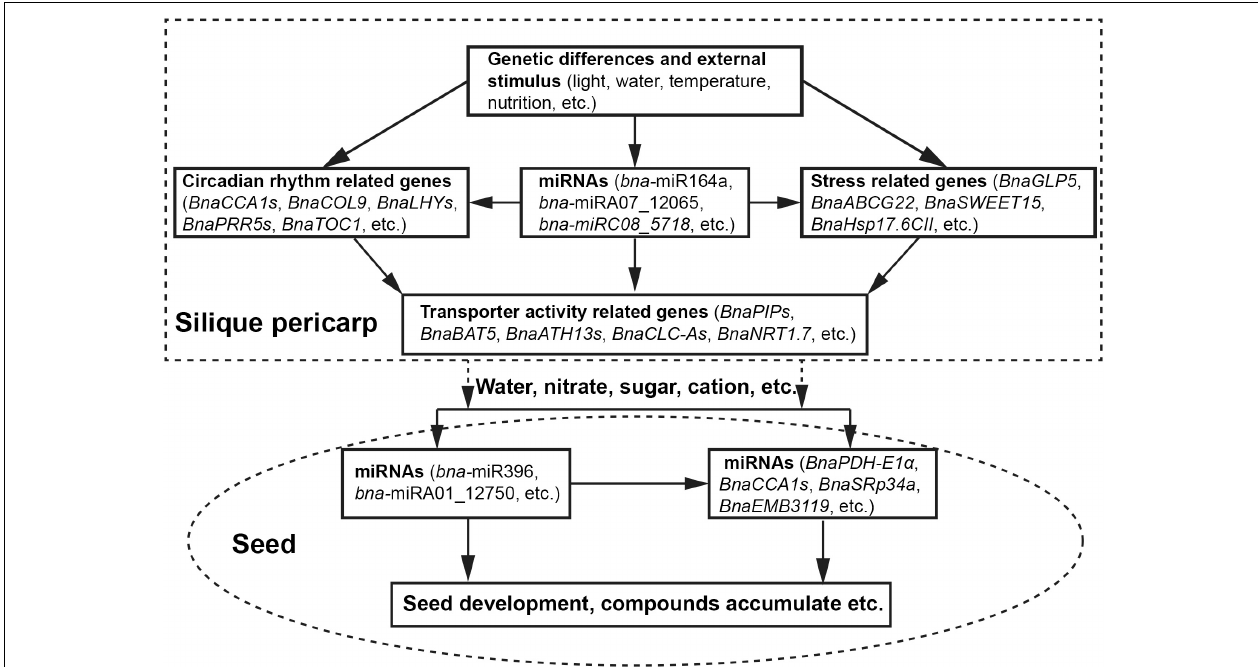
FIGURE 6 | A proposed model for HI determination during the seed-filling stage.